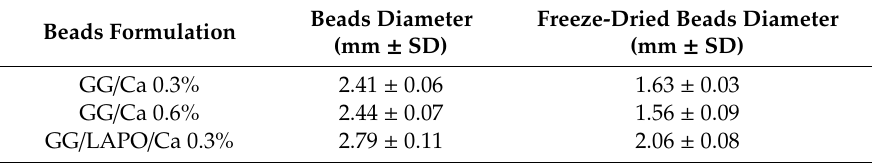
Table 1. Diameter values of di ff erent bead formulations before and after